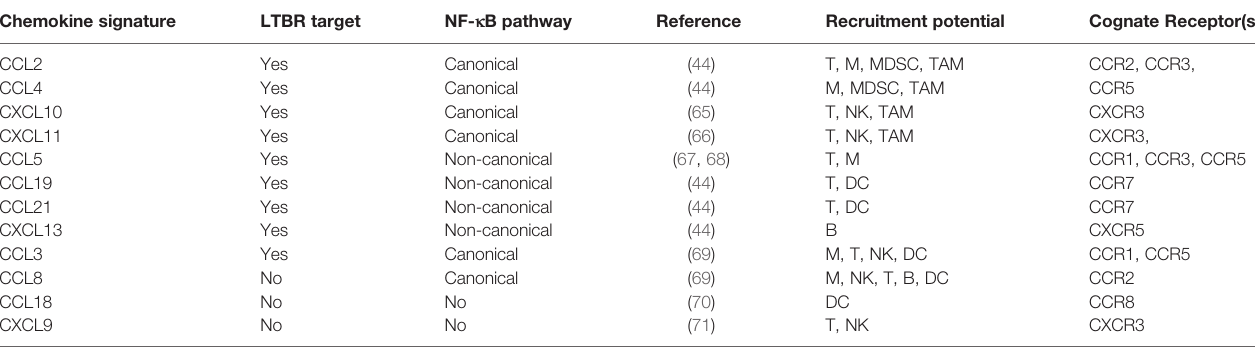
TABLE 1 | 12CK-GES and associated NF- k B signaling